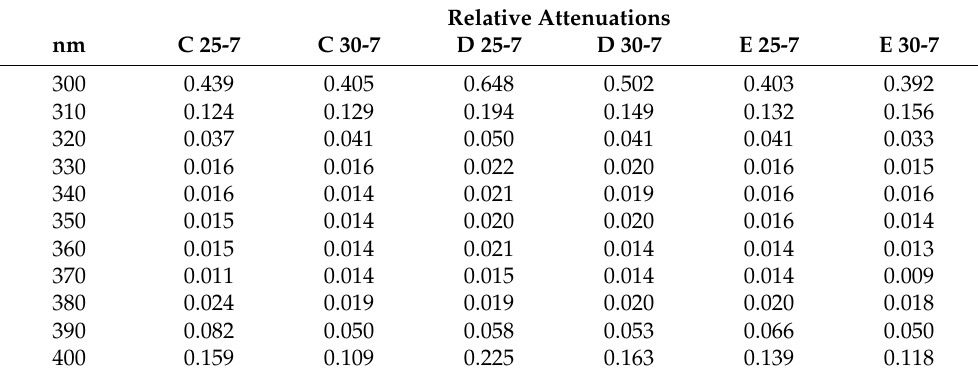
Table 7. Values of the spectral relative attenuations for the UV band for the three interior locations for the two skylights without (25-7) and with water (30-7) at 9 a.m. solar time. Relative Attenuations